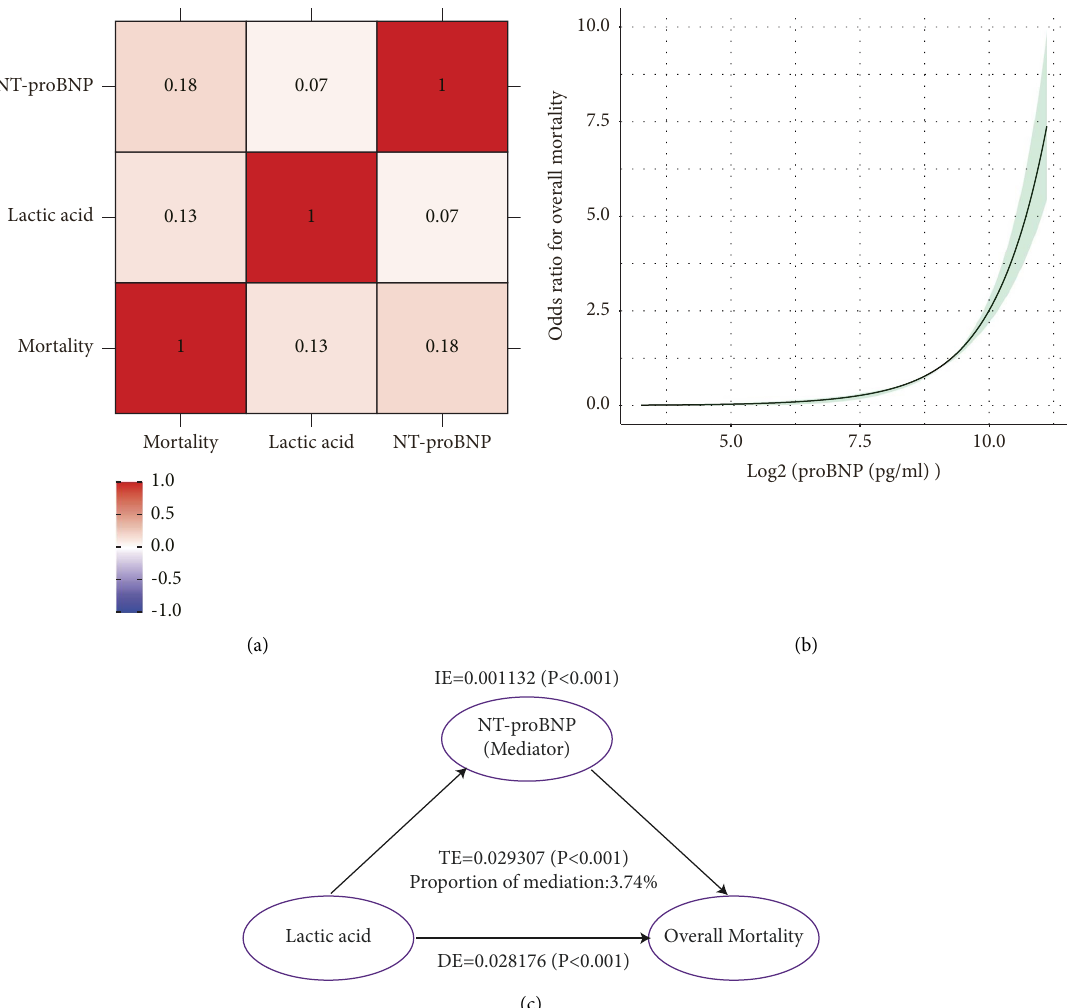
Figure 4: Te association between NT-proBNP, lactic acid, and the risk of in-hospital all-cause death. (a) Correlation matrix of NT- proBNP, lactic acid, and the risk of in-hospital all-cause death. (b) Restricted cubic spline plots of associations between NT-proBNP levels and in-hospital all-cause mortality. Note: Analyses were adjusted for age, ethnicity, body mass index, weight, systolic blood pressure, the history of atrial fbrillation, liver cirrhosis, acute myocardial infarction, chronic kidney disease, respiratory failure, chronic obstructive pulmonary disease, ventricular fbrillation, diabetes mellitus, septicaemia, anion gap, bicarbonate, blood urea nitrogen, calcium, serum creatinine, glucose, hematocrit, hemoglobin, platelet, red blood cells, C reactive protein, length of stay, albumin, white blood cells, lactic acid, cardiotonic drugs, nitroglycerin drugs, furosemide drugs, infection-fghting drugs, Simplifed Acute Physiology Score II, and sequential organ failure assessment. Te solid line and dashed line represent the log-transformed odds ratios and corresponding 95% confdence intervals. (c) Mediation analysis of NT-proBNP on the interaction between lactic acid levels and in-hospital all-cause death. Notes: Mediation models of NT-proBNP, lactic acid, and in-hospital all-cause death in data: direct efect (TE � 0.029307; P < 0 . 001) of lactic acid (exposure) toward in-hospital all-cause death (outcome), and NT-proBNP medication proportion is 5.9%; indirect efect (IE � 0.001132; P < 0 . 001) of lactic acid (exposure) toward NT-proBNP (mediator) and efect obesity (DE � 0.028176; P < 0 . 001), from NT-proBNP (mediator) toward in-hospital all-cause death